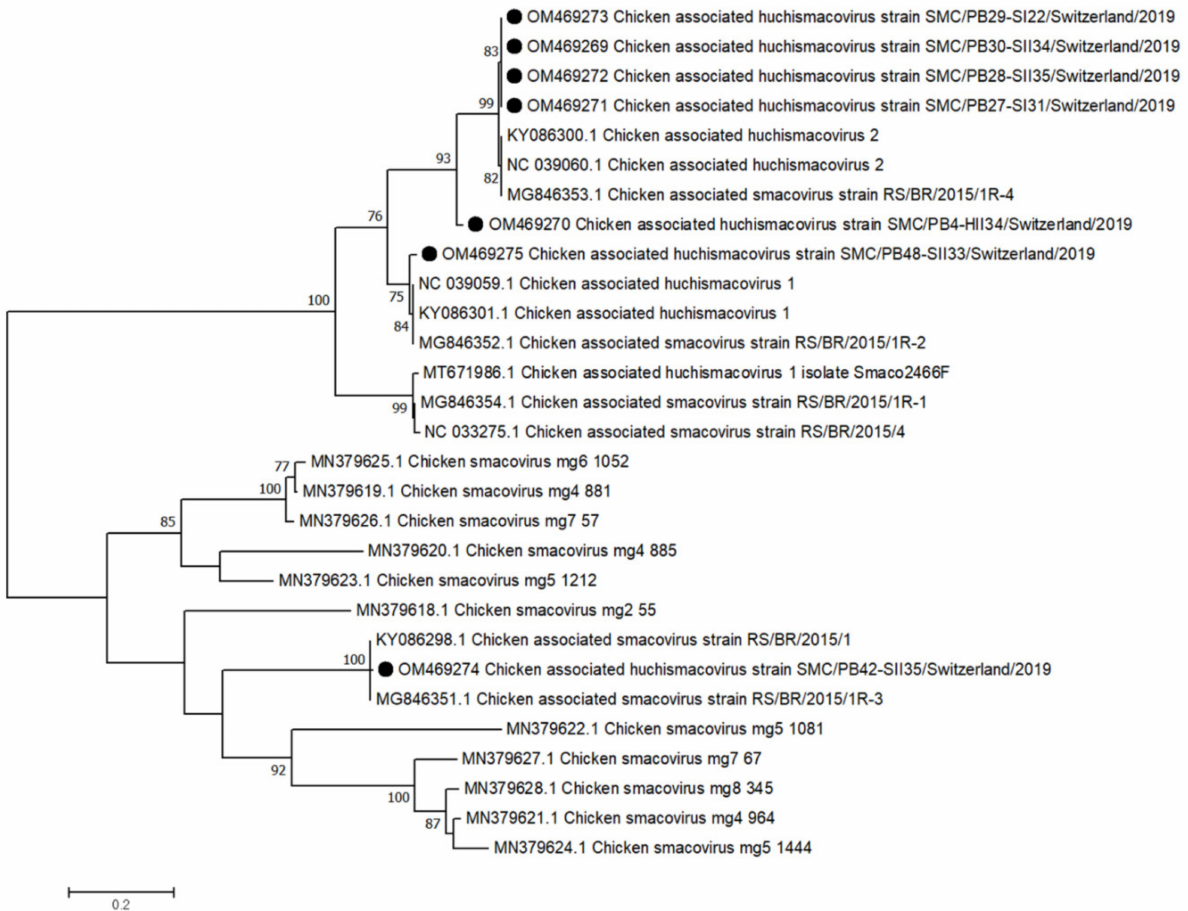
Figure 7. Phylogenetic tree based on the amino acid sequence identity of the Rep protein of selected chicken smaco/huchismacoviruses. Huchismacovirus contigs obtained in this study are marked with black dots. Phylogenetic analysis was performed using the maximum likelihood algorithm based on the Tamura–Nei model with the 1000 replication bootstrap method. Only values ≥ 70% were displayed. Evolutionary analyses were conducted using MEGA